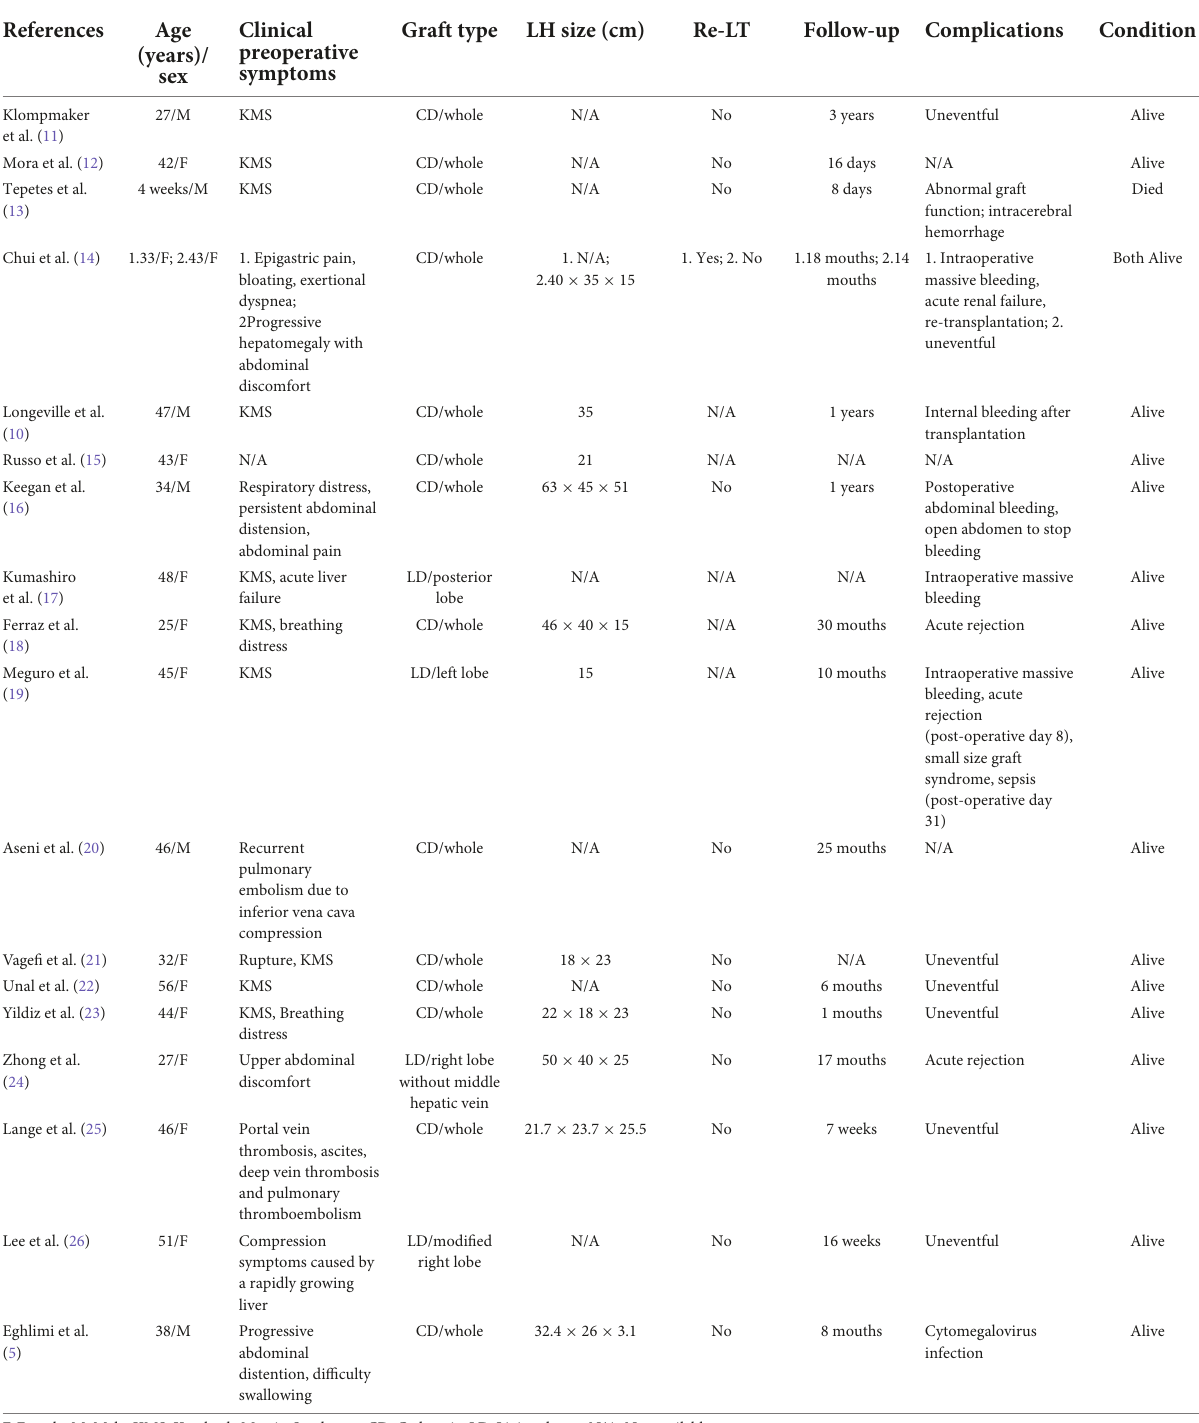
TABLE 1 Current literature on liver transplantation for hepatic hemangioma.